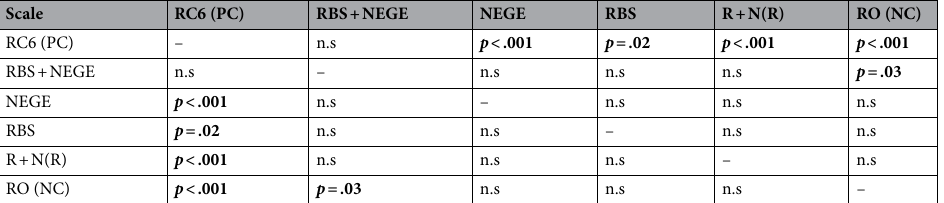
Table 1. Post-hoc Tukey test results in regards of model performance to predict Fenigstein & Vanable participants’ responses matrix. [n.s.: not significant; RC6 (PC): Restructured Clinical 6 (Positive Control); NEGE: Neuroticism Scale; RBS: Responses Biases Scales; R + N(R): RBS + NEGE (Reduced); RO (NC): Random Observations (Negative Control)]. Significant values are in